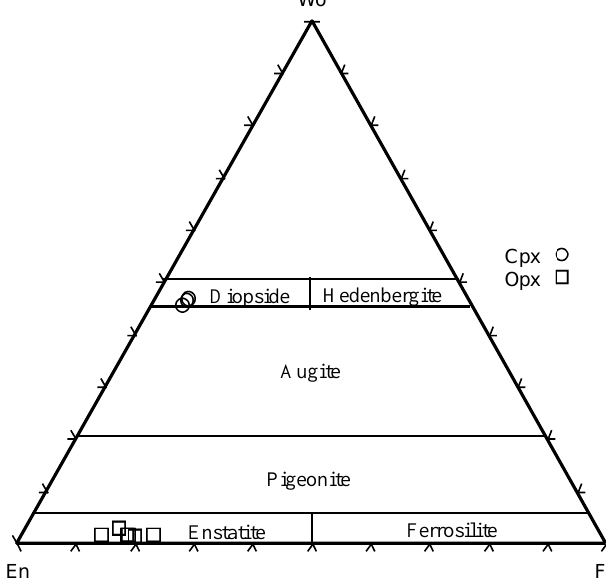
Figure 4. Enstatite – Diopside – Ferrosilite (En – Di – Fs; Morimoto [18]), trilinear diagram for the pyroxene compositions in the Holenarsipur high-Si high-Mg volcanics.